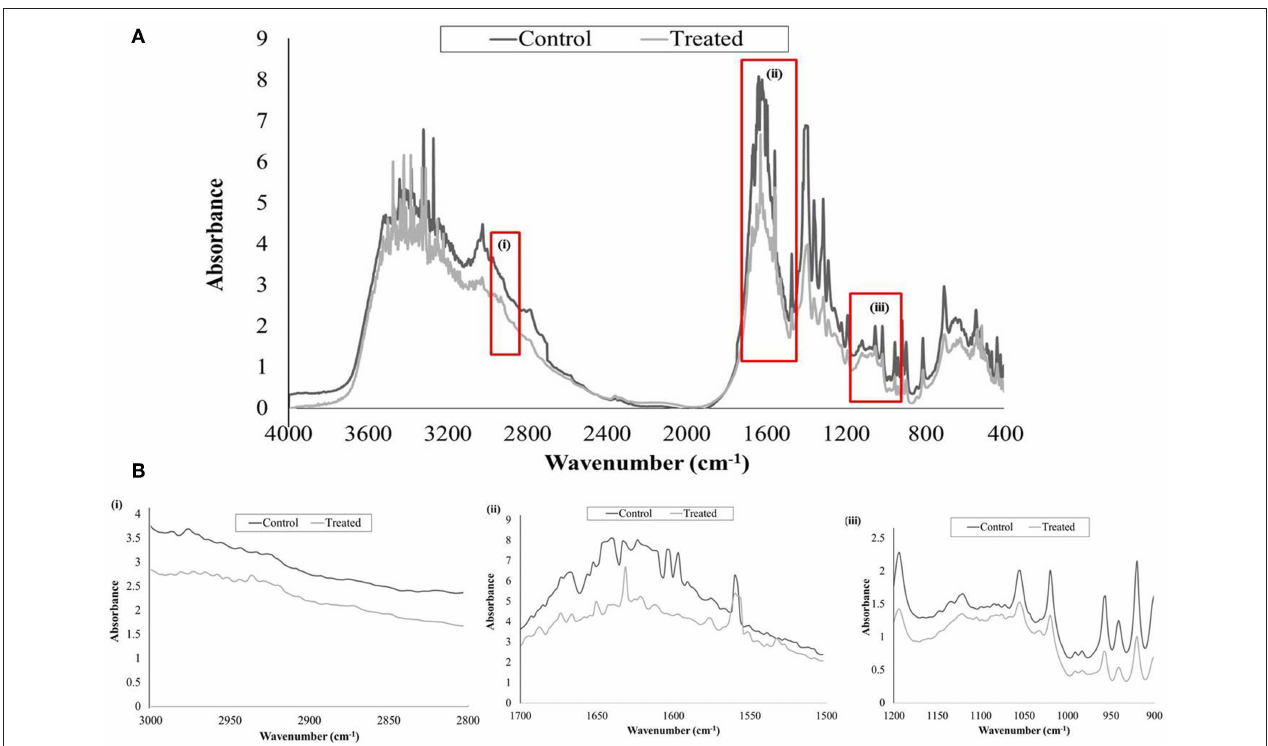
FIGURE 7 | FTIR analysis of untreated and UMB (at 500 µ g/ml) treated MRSE, EPS. (A) Spectra of control and UMB treated MRSE, EPS scanned in the range of 4,000–400 cm − 1 , specifying the regions corresponding to (i) lipids (3,000–2,800 cm − 1 ); (ii) amide bonds of proteins & peptides (1,700–1,500 cm − 1 ); and (iii) polysaccharides (1,200–900 cm − 1 ). (B) Enlarged images of highlighted spectral regions (i), (ii), and (iii).